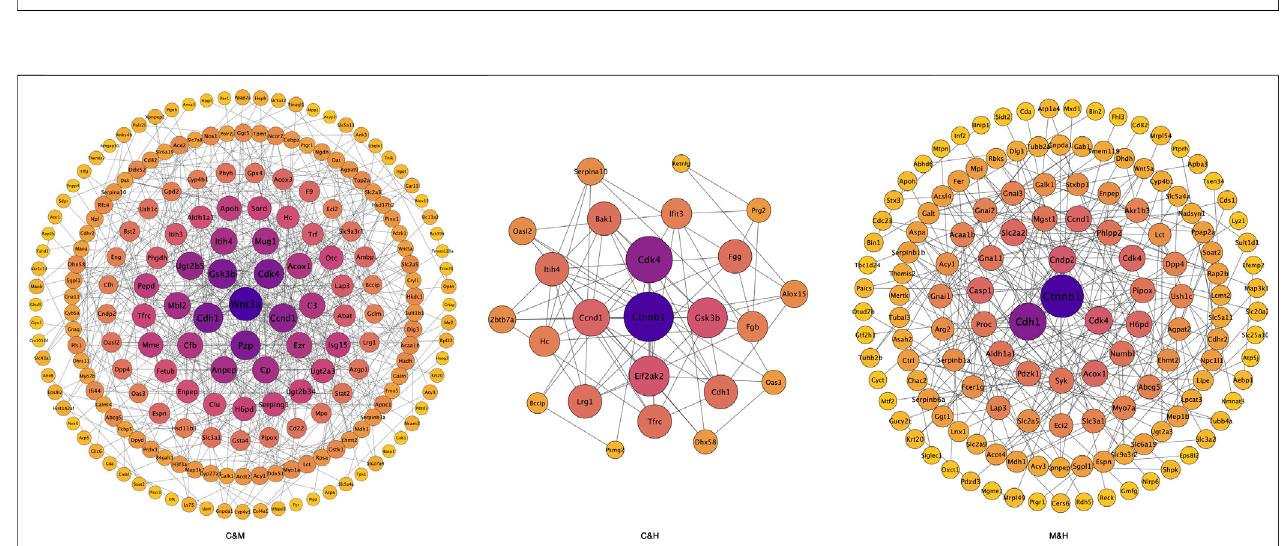
FIGURE 9 | Protein – protein interactions network diagram. Each node in the interaction network represents a protein, the size of the node indicates the number of proteins interacting with it, with larger node indicating more proteins interacting with it, and the color of the node indicates the expression level of the protein, with darker colors indicating higher expression levels. C: normal control; M: model control; H: HQT control, n = 3.